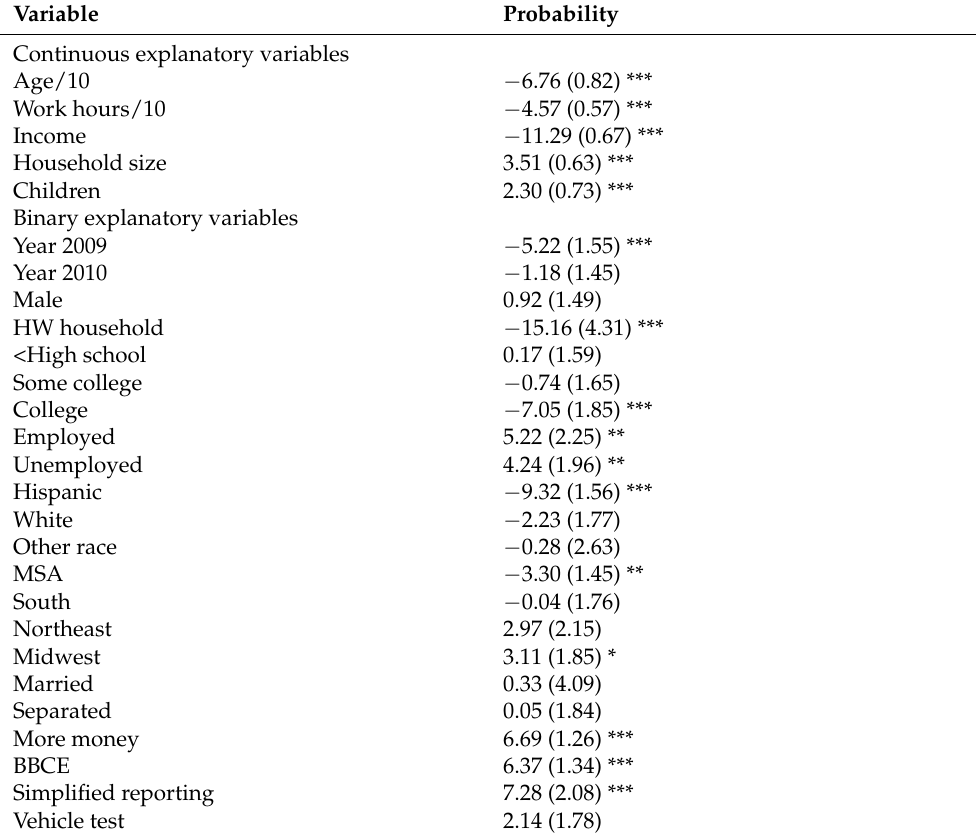
Table 3. Average marginal effects of explanatory variables on the probability of SNAP